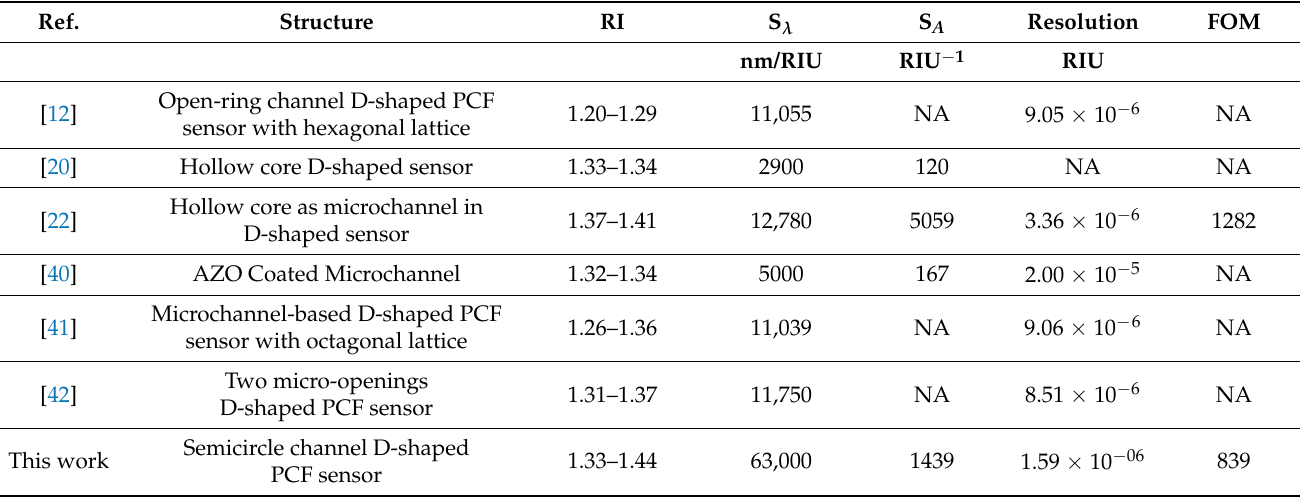
Table 2. Performance evaluation of existing open channel sensors in terms of sensing parameters with the proposed